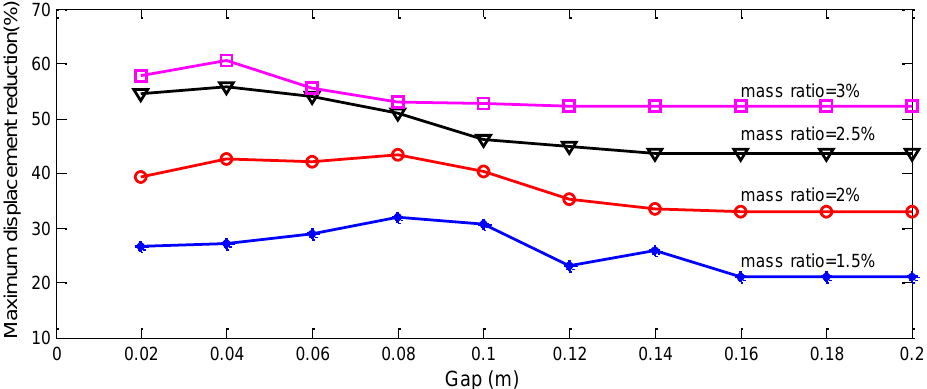
Figure 14. Displacement vibration reduction ratio of the tower with different mass ratios.